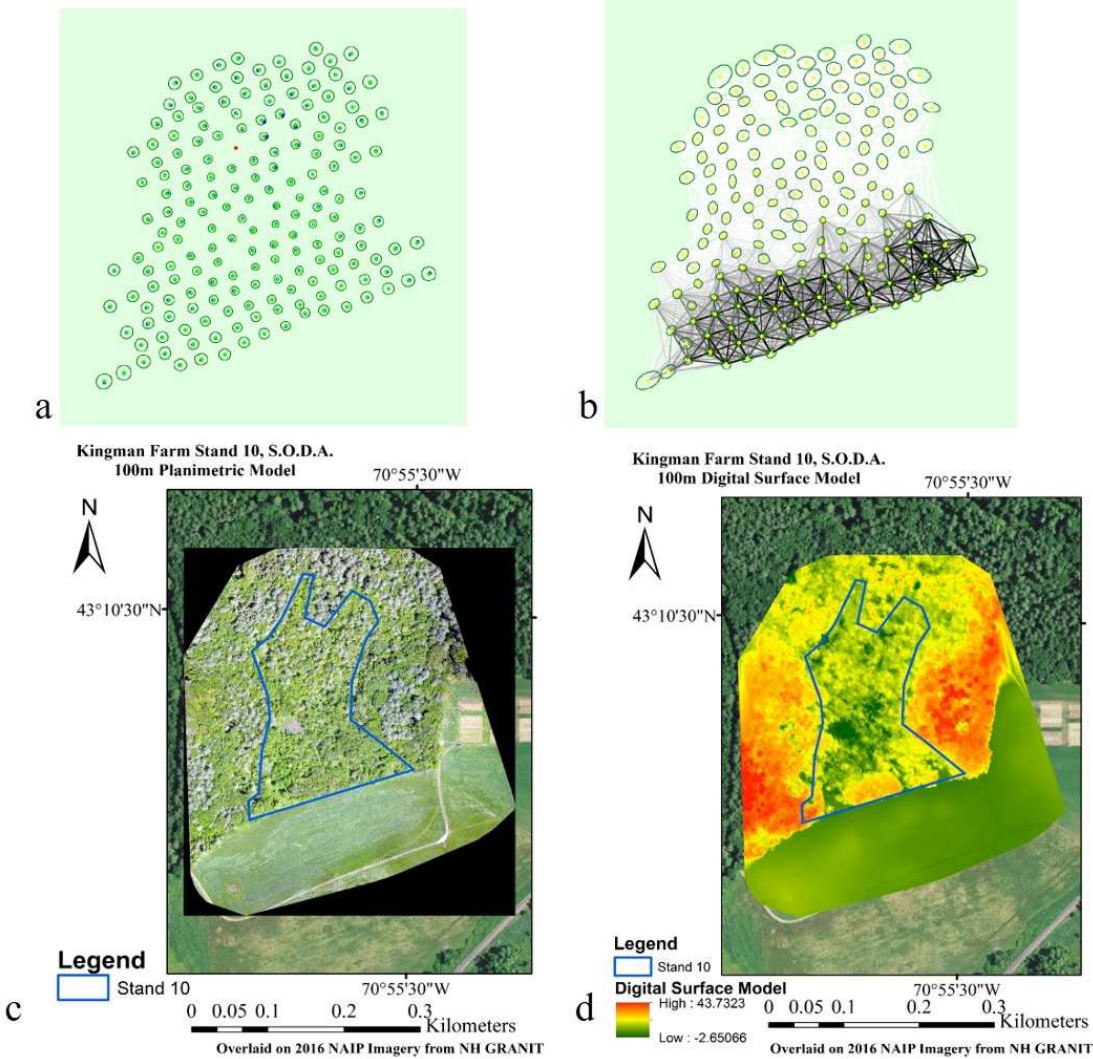
Figure 5. Pix4D Mapper Pro initial processing results for the S.O.D.A at a 100-m flying height above the canopy height model: ( a ) image alignment success (green), failure (red), and uncertainty (blue); ( b ) image-matching strength (weight of line network) and image geolocation certainty (circle area); ( c ) final orthomosaic product; and ( d ) DSM.